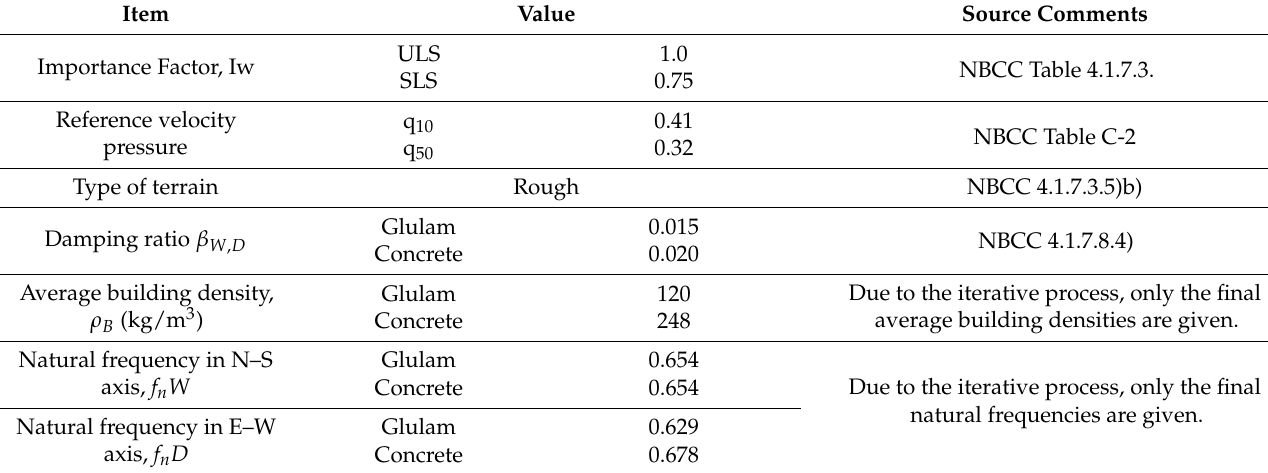
Table 2. Wind loads’ design